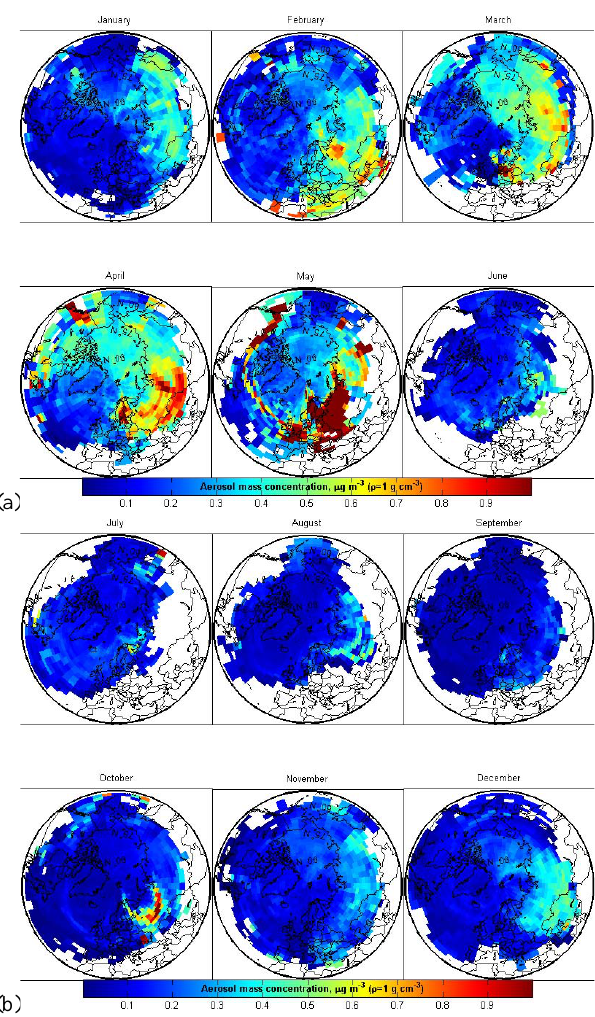
Fig. 13. Monthly maps showing the average concentration of sub- micron mass observed at Svalbard after crossing different source areas. Data represent months January–June (a) and July–December (b) , years 2000–2010 (see text for details).